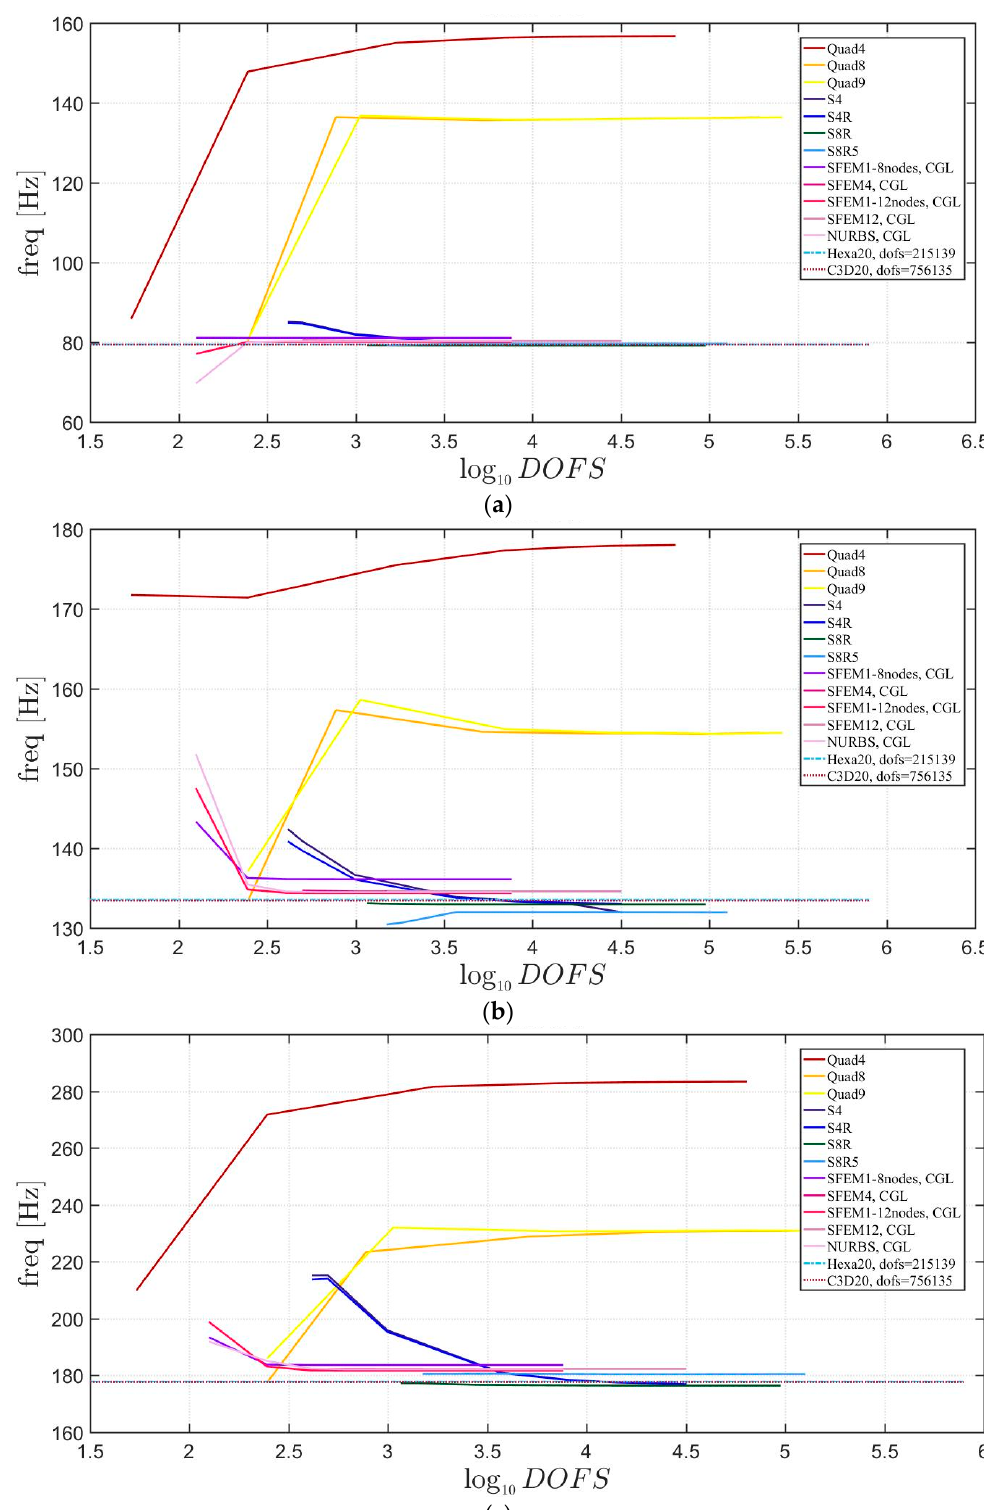
Figure 25. First three natural frequencies of an elliptic plate with a / b = 2.5 a symmetric lamination scheme and a / h = 10: ( a ) First frequency; ( b ) Second frequency; ( c ) Third frequency.